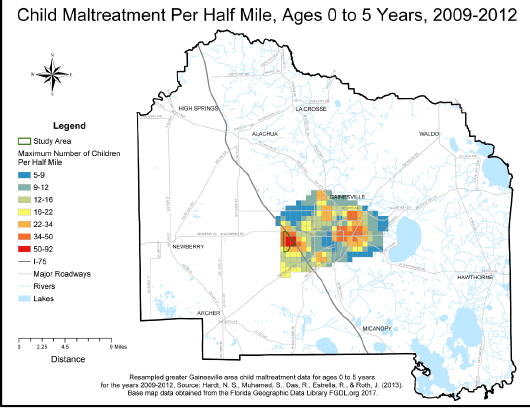
Figure 1. Child Maltreatment Density Map.